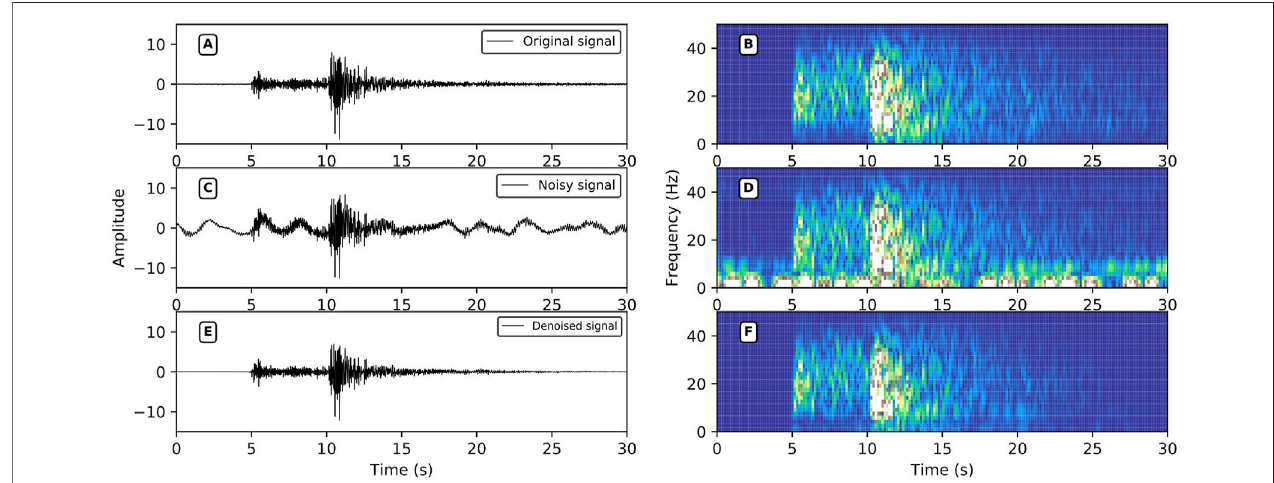
FIGURE 8 | Low-frequency noise reduction performance. (A,C,E) are the original signals, the noise signal, and the signal after noise reduction in the time domain; (B,D,F) are the time-frequency domain data of (A,C,E) ; the signal SNR after adding noise (cid:1) 0.21 dB, r (cid:1) 0.7011, SNR after noise reduction (cid:1) 12.84 dB, r (cid:1) 0.9778.